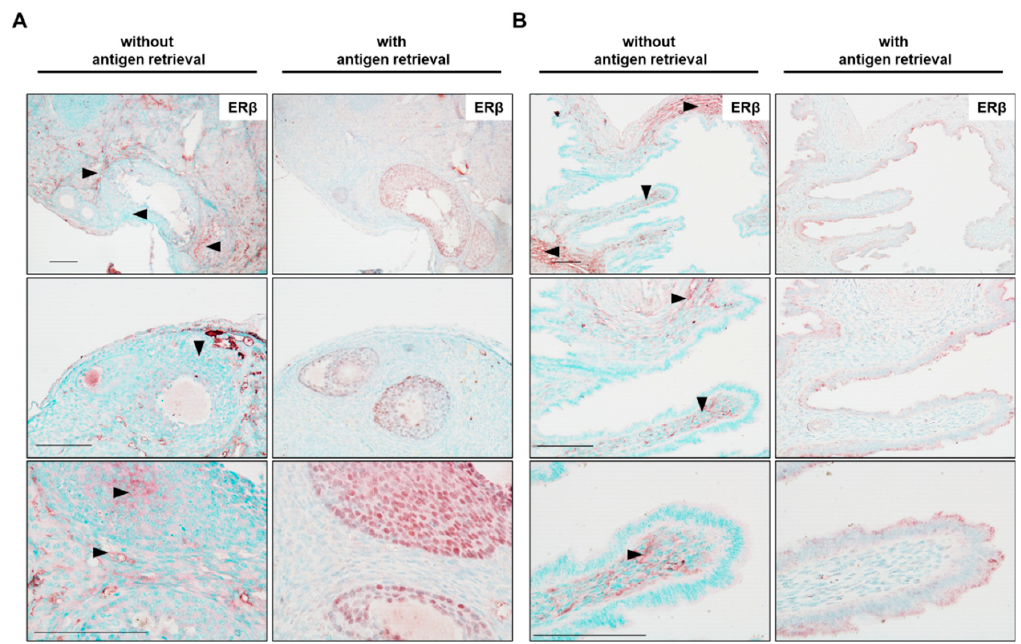
Figure 2. Heat-induced antigen retrieval is mandatory to obtain specific nuclear estrogen receptor beta (ER β ) staining. Murine ovaries ( A ) or uterine tissue ( B ) were used to evaluate whether antigen unmasking is required for specific nuclear ER β staining using PPZ0506 antibody. Some sections were stained without antigen retrieval, whereas in others antigen retrieval was performed by heating the sections in sodium citrate buffer (10 mM, 0.05% Tween 20, pH 6.0) in a steamer